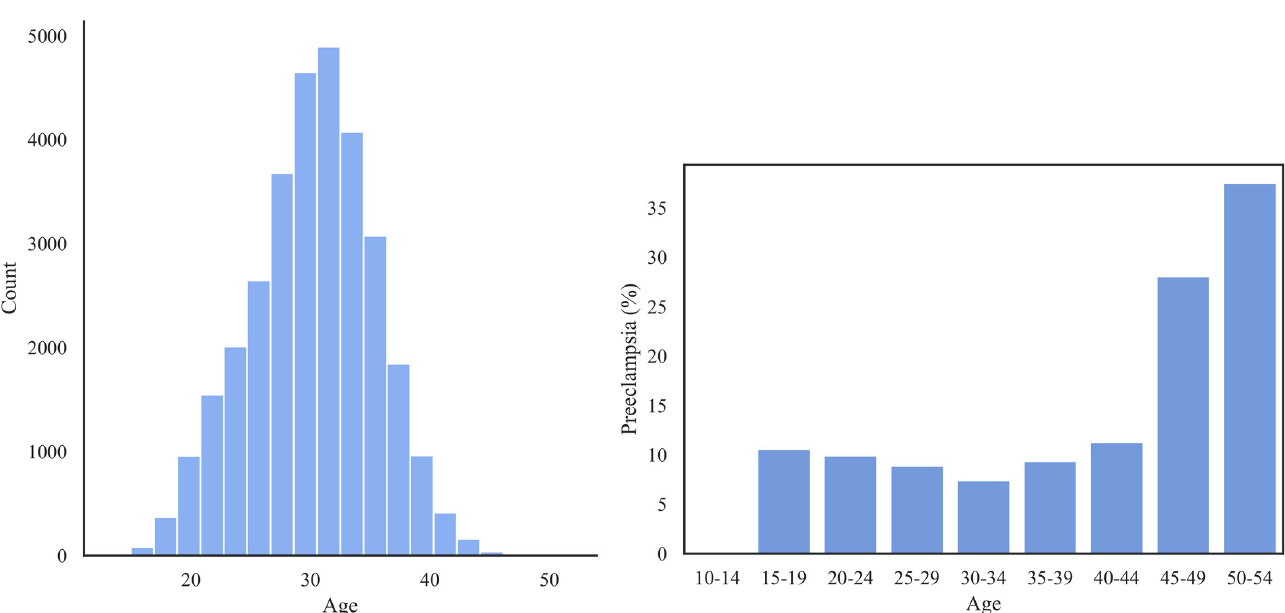
PLOS ONE | https://doi.org/10.1371/journal.pone.0266042 April 6,